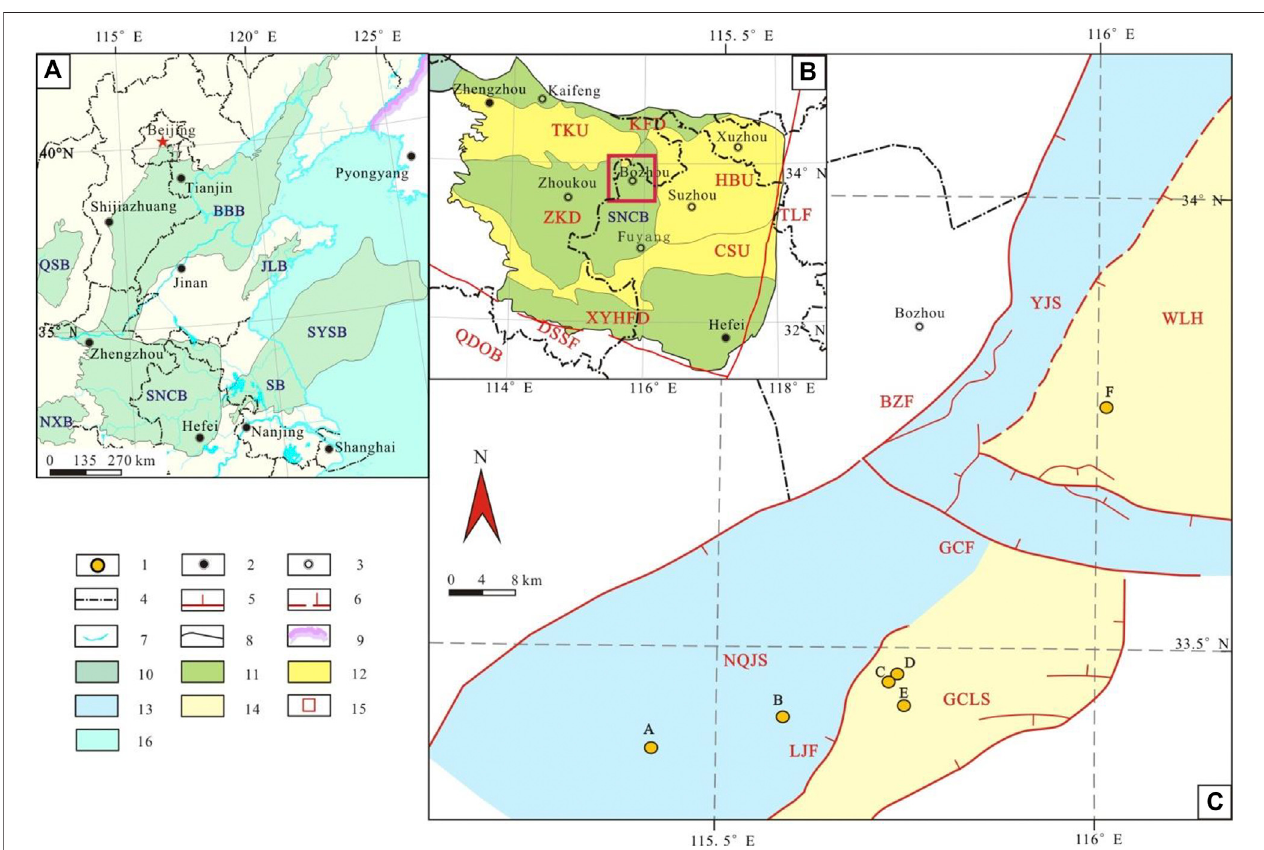
FIGURE 1 | Geological structure outline map of the northeastern part of the Zhoukou Depression. BBB, Bohai Bay Basin; BZF, Bozhou Fault; CSU, Changshan Uplift; DSSF, Danfeng-Shangnan-Shangcheng Fault; GCF, Gucheng Fault; GCLS, Gucheng lower high; HBU, Huaibei Uplift; JLB, Jiaolai Basin; KFD, Kaifeng Depression; LJF, Luoji Fault; NQJS, Niqiuji Sag; NXB, Nanxiang Basin; QDOB, Qinling-Dabie Orogenic Belt; QSB, Qinshui Basin; SB, Subei Basin; SNCB, South North China Basin; SYSB, South Yellow Sea Basin; TLF, Tan-Lu Fault; WLH, Wanglou High; XYHFD, Xinyang-Hefei Depression; YJS, Yanji Sag; ZKD, Zhoukou Depression. 1. Well location; 2. Provincial city; 3. Prefecture-level city; 4. Provincial boundary; 5. Normal fault; 6. Reverse fault; 7. Coastline, river, or lake; 8. Basin boundary; 9. National boundary; 10. Basin; 11. Depression; 12. Uplift; 13. Sag; 14. High; 15. The study area; 16. Sea. (A) Geological structure outline map of Southern North China Basin (SNCB); (B) Geological structure outline map of Zhoukou Depression (ZKD); (C) Geological structure outline map of research fi led.